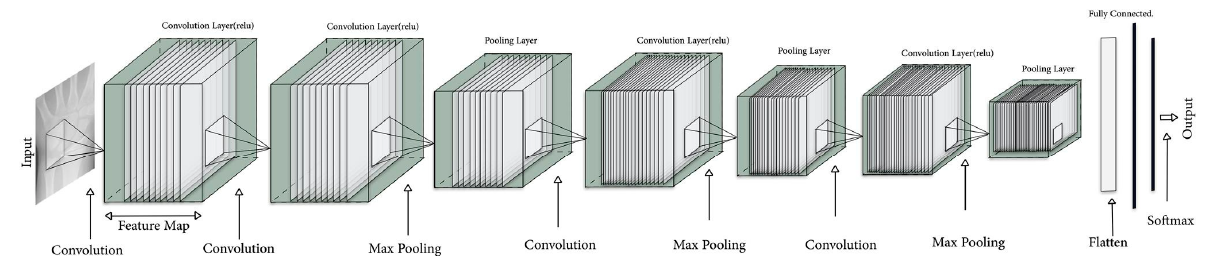
Figure 2. Preprocessing-Extraction of ROI Regions.